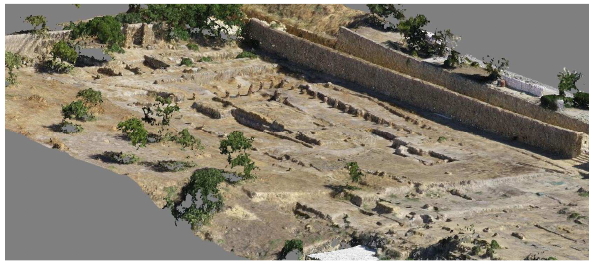
Figure 8. 3D model of the Temple of Isis